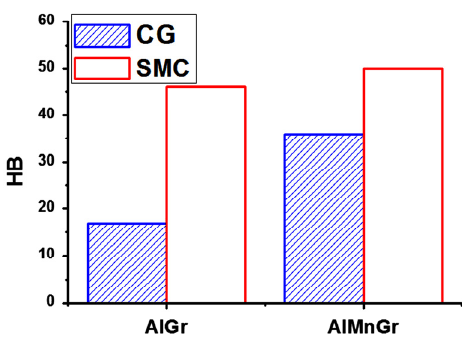
Figure 10. The hardness of aluminum matrix composites with different grain sizes.